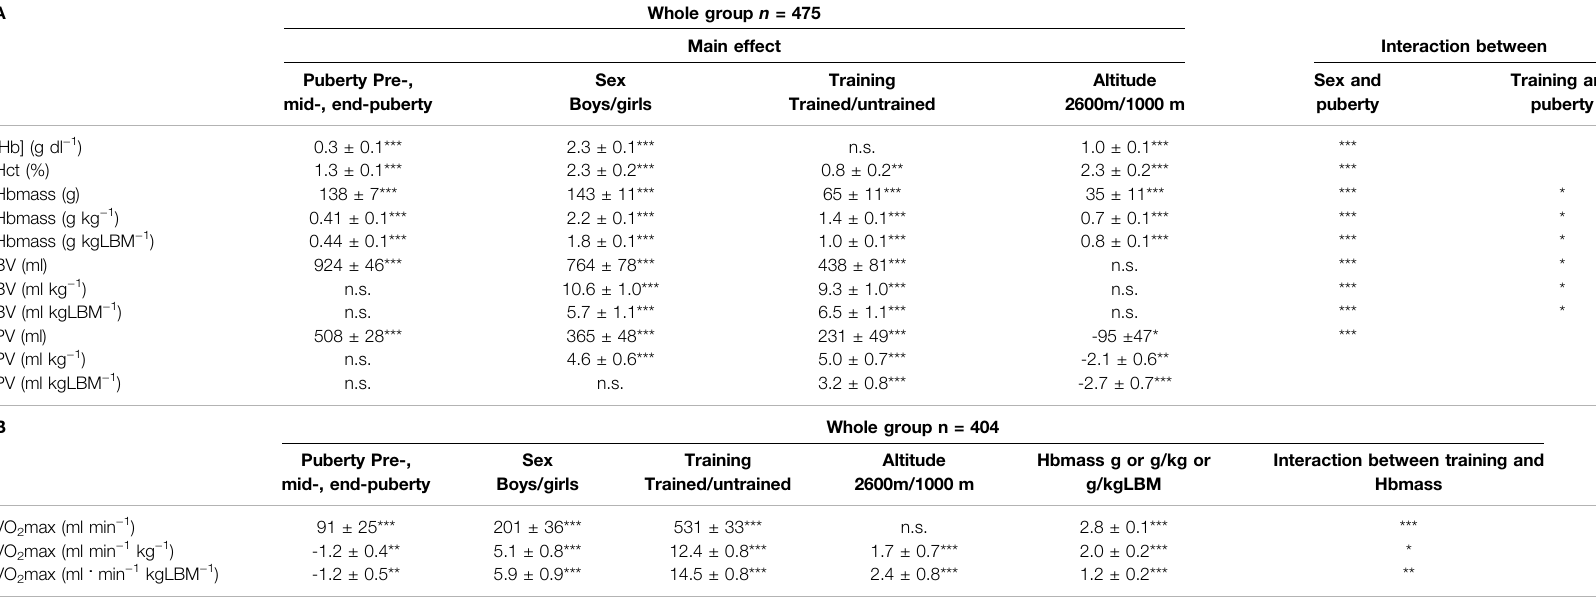
Presentedaresigni fi cantmaineffectswithstandarderrorsandinteractions.Theeffectswerecalculatedasdescribedinstep3inthestatisticssectionbymultipleregressionanalysis.[Hb],hemoglobinconcentration;Hct,hematocrit;Hbmass, hemoglobin mass; BV, blood volume; PV, plasma volume; LBM, lean body mass. Signi fi cance of effects: * p < 0.05, **p < 0.01, ***p < 0.001, n.s., not signi fi cant.